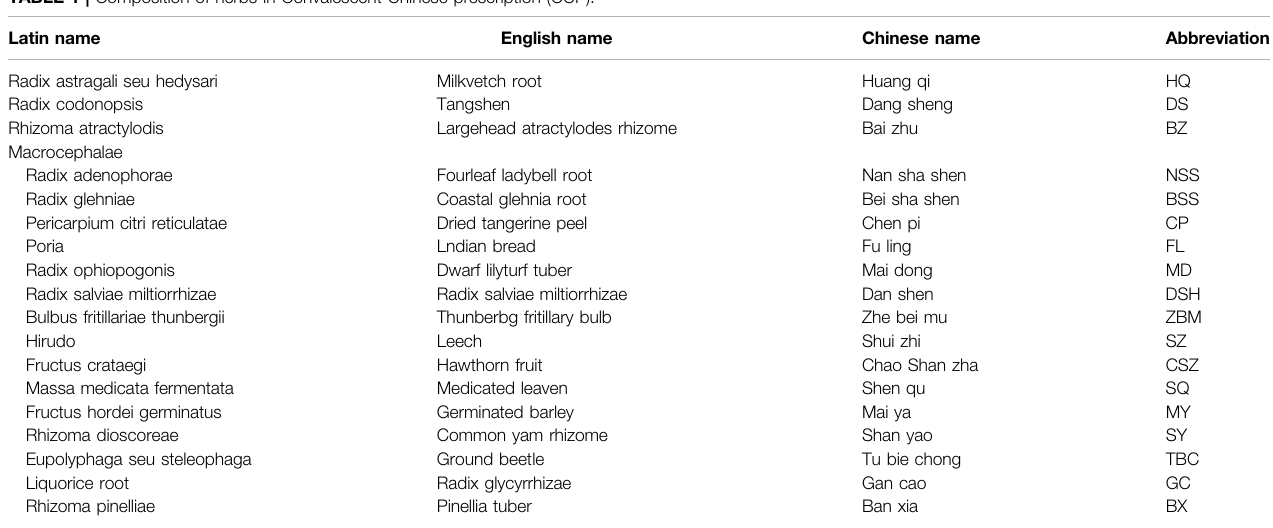
TABLE 1 | Composition of herbs in Convalescent Chinese prescription